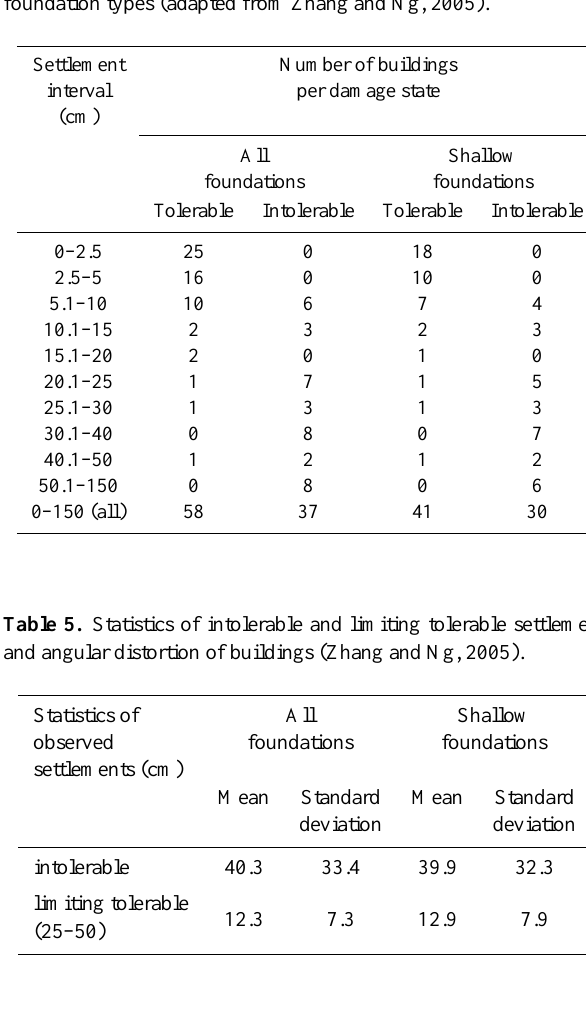
Table 4. Number of buildings out a total of 95, observed in each state (“tolerable” or “intolerable” settlement case), with respect to different intervals of settlement values, and considering different foundation types (adapted from Zhang and Ng, 2005).